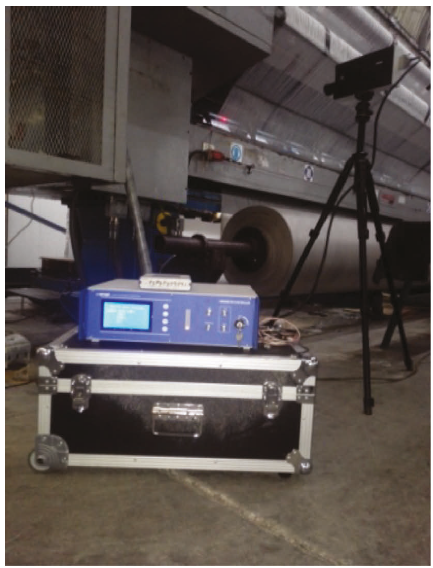
Figure 5: Vibration test